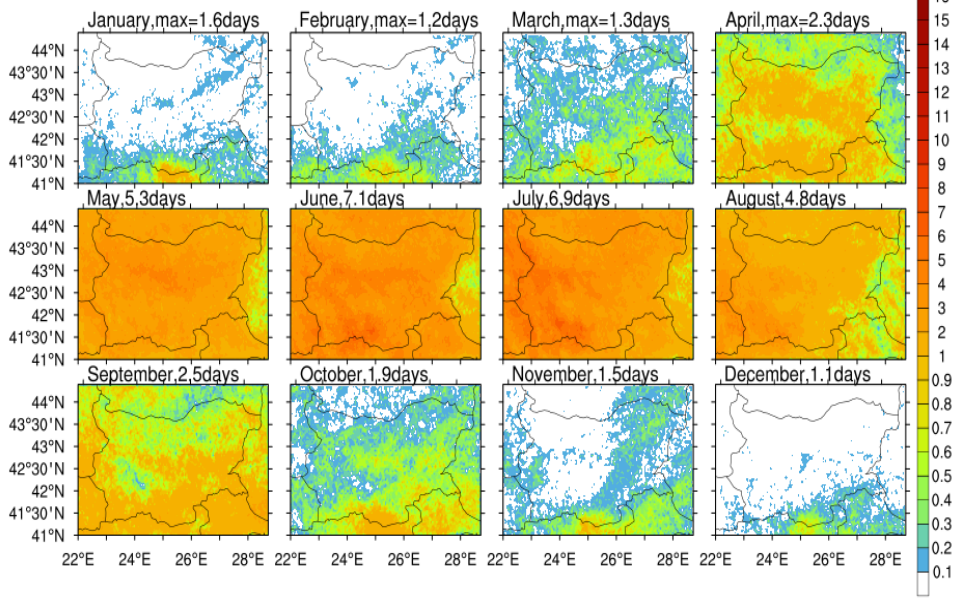
Figure 14. Mean monthly spatial distribution of days with flashes according to ATDnet (spatial resolution: 0.05 × 0.05deg) spatial (on a grid of 0.05 × 0.05 deg).